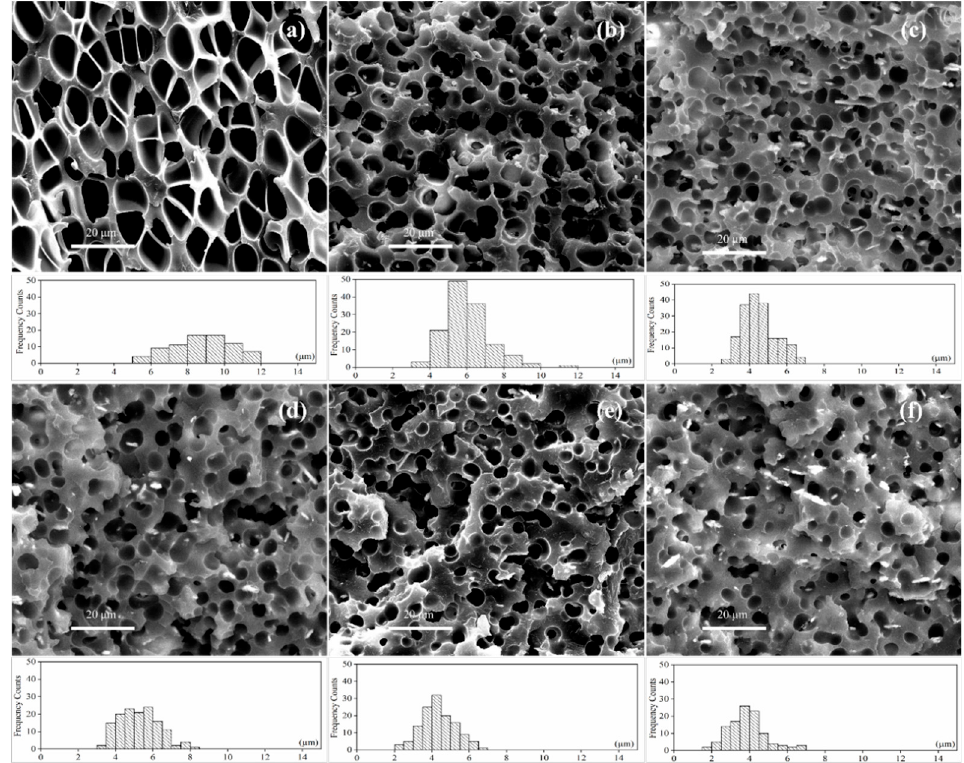
Figure 6. SEM micrographs of SAN/CPE foams. ( a ) Neat SAN; ( b ) 10 wt.% CPE; ( c ) 20 wt.% CPE; ( d ) 30 wt.% CPE; ( e ) 40 wt.% CPE; ( f ) 50 wt.% CPE. All samples were foamed at 130 °C and 25 MPa via